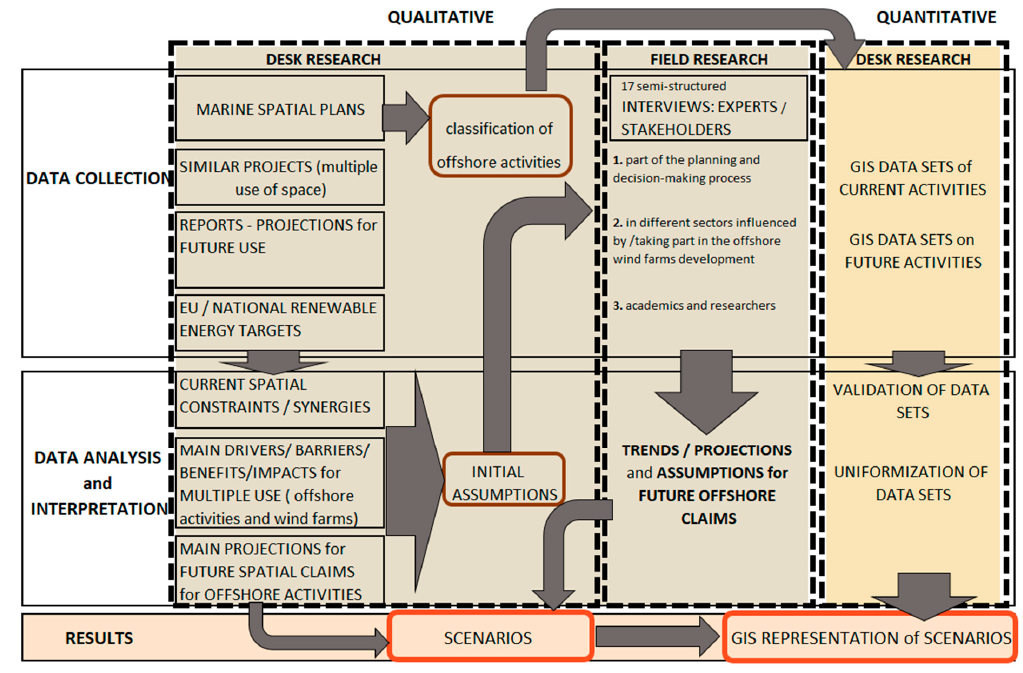
Figure A1. Methodological steps. Table A2. Glossary .